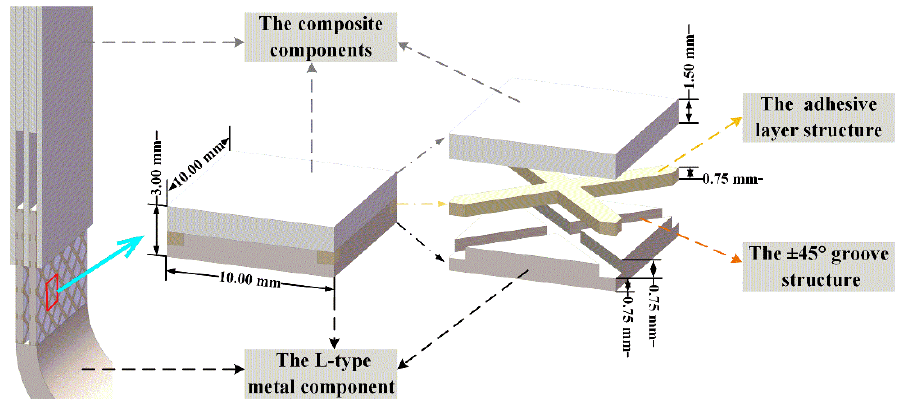
Figure 5. Compression test of metal-composite L-joint and direction of force.